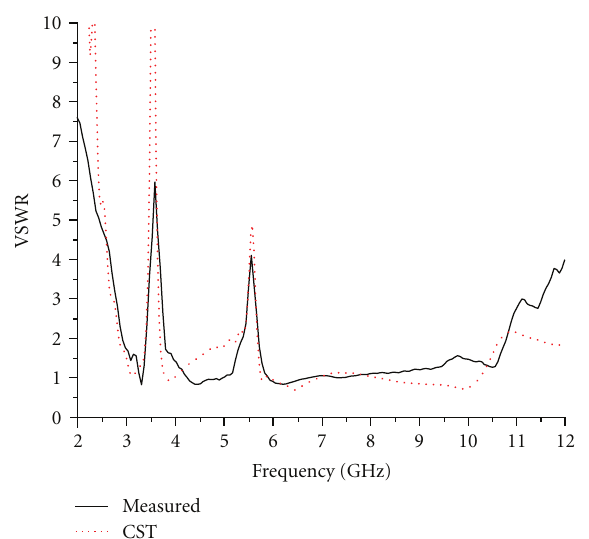
Figure 5: Simulated and measured VSWR of the proposed dual band-notched antenna.